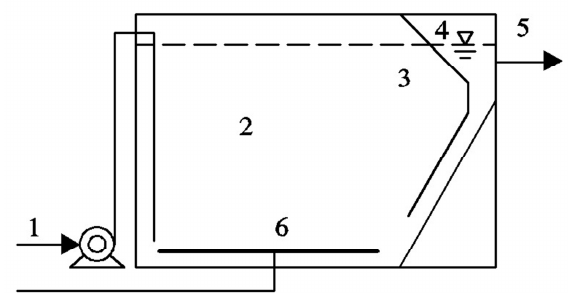
Figure 2. Structure diagram of ABS system and CAS system for printing and dyeing wastewater reactor: (1) influent zone, (2) biochemical reaction zone, (3) three-phase separator, (4) sedimentation zone, (5) effluent zone, (6) Aeration tube.